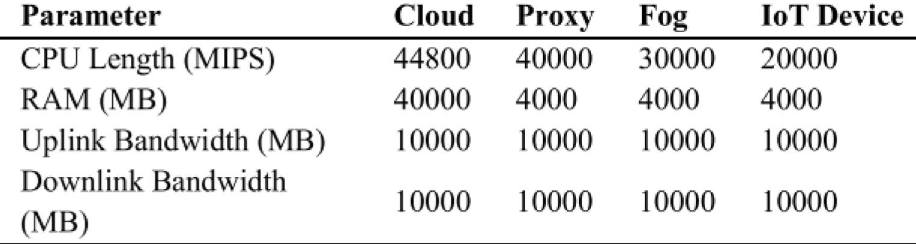
Table 2 Topology